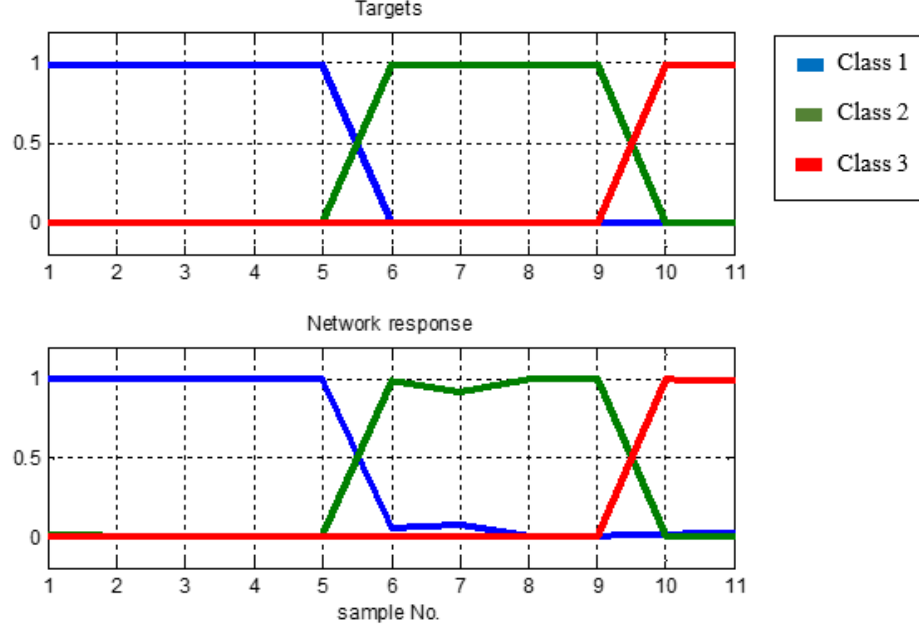
Figure 8. Network response to the targets class.